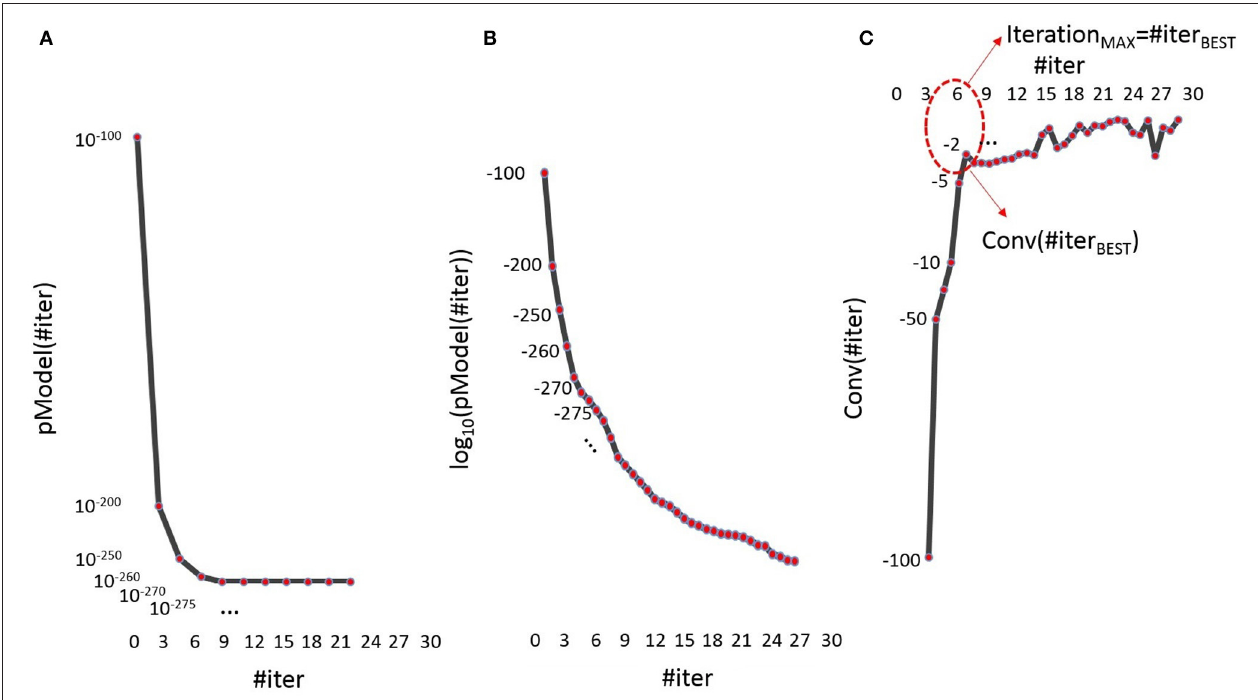
FIGURE 2 | Representation of the (A) pModel vector, the (B) log10 of the pModel vector and the (C) Conv function for each iteration, for a representative subject. In particular, in the figure (C) there are also showed (i) the Conv(#iterBEST), in other words the lower distance of the Conv(#iter) function from the point (0,0) and (ii) the correspondent IterationMAX, that is